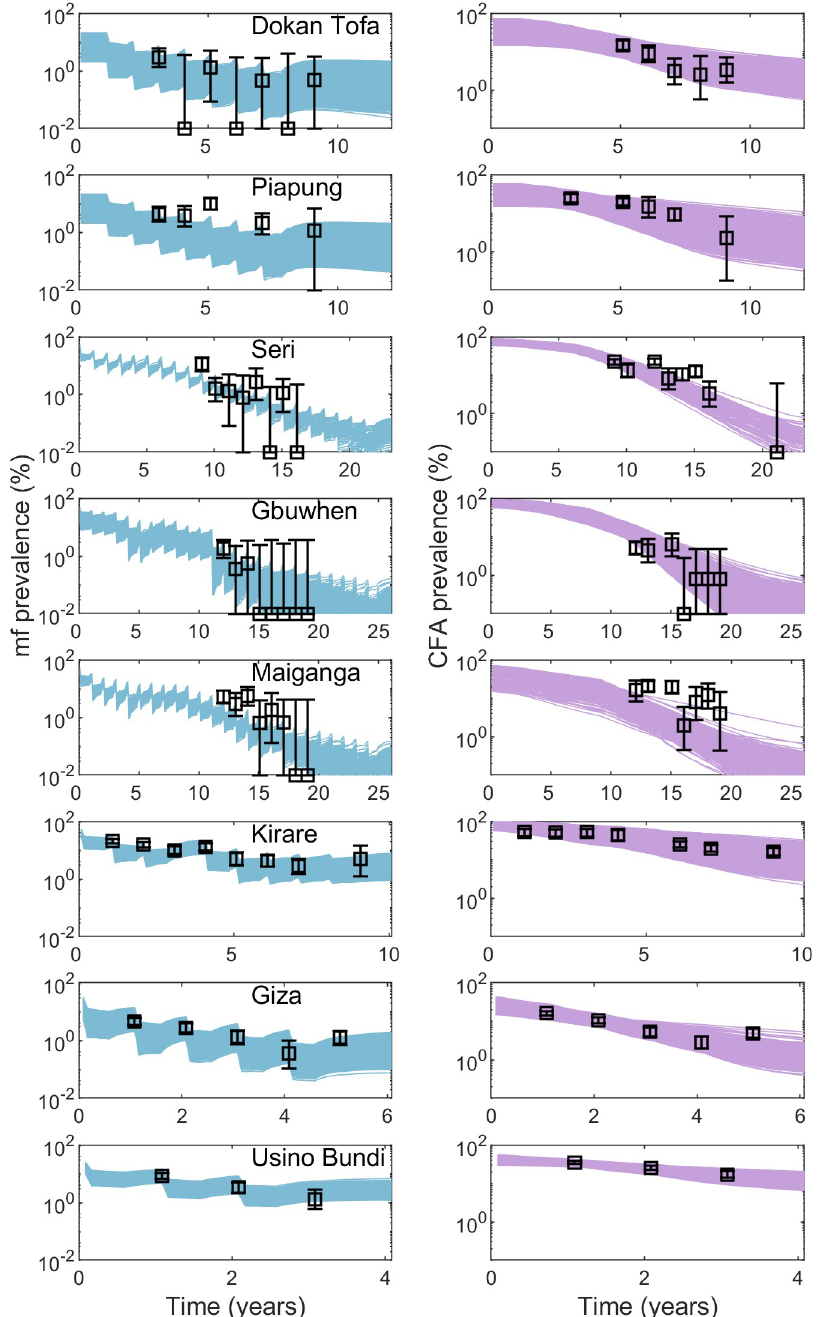
Fig 4. Model forecasts of post-intervention mf and CFA prevalence compared to observed survey data. Each row of plots give the model-predicted mf (left, blue curves) and CFA (right, purple curves) prevalence over time during the site-specific MDA program. Black points represent the surveyed prevalence with the corresponding 95% confidence